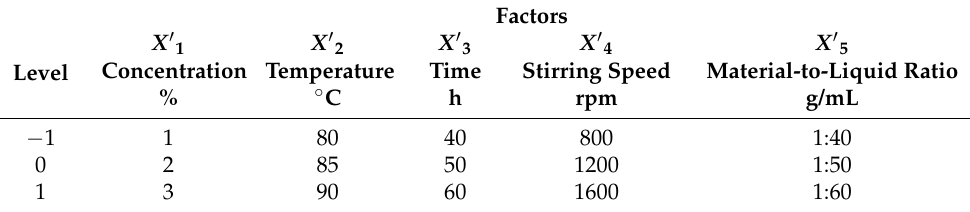
Table 2. Codes and levels of independent variables during surfactant aqueous phase